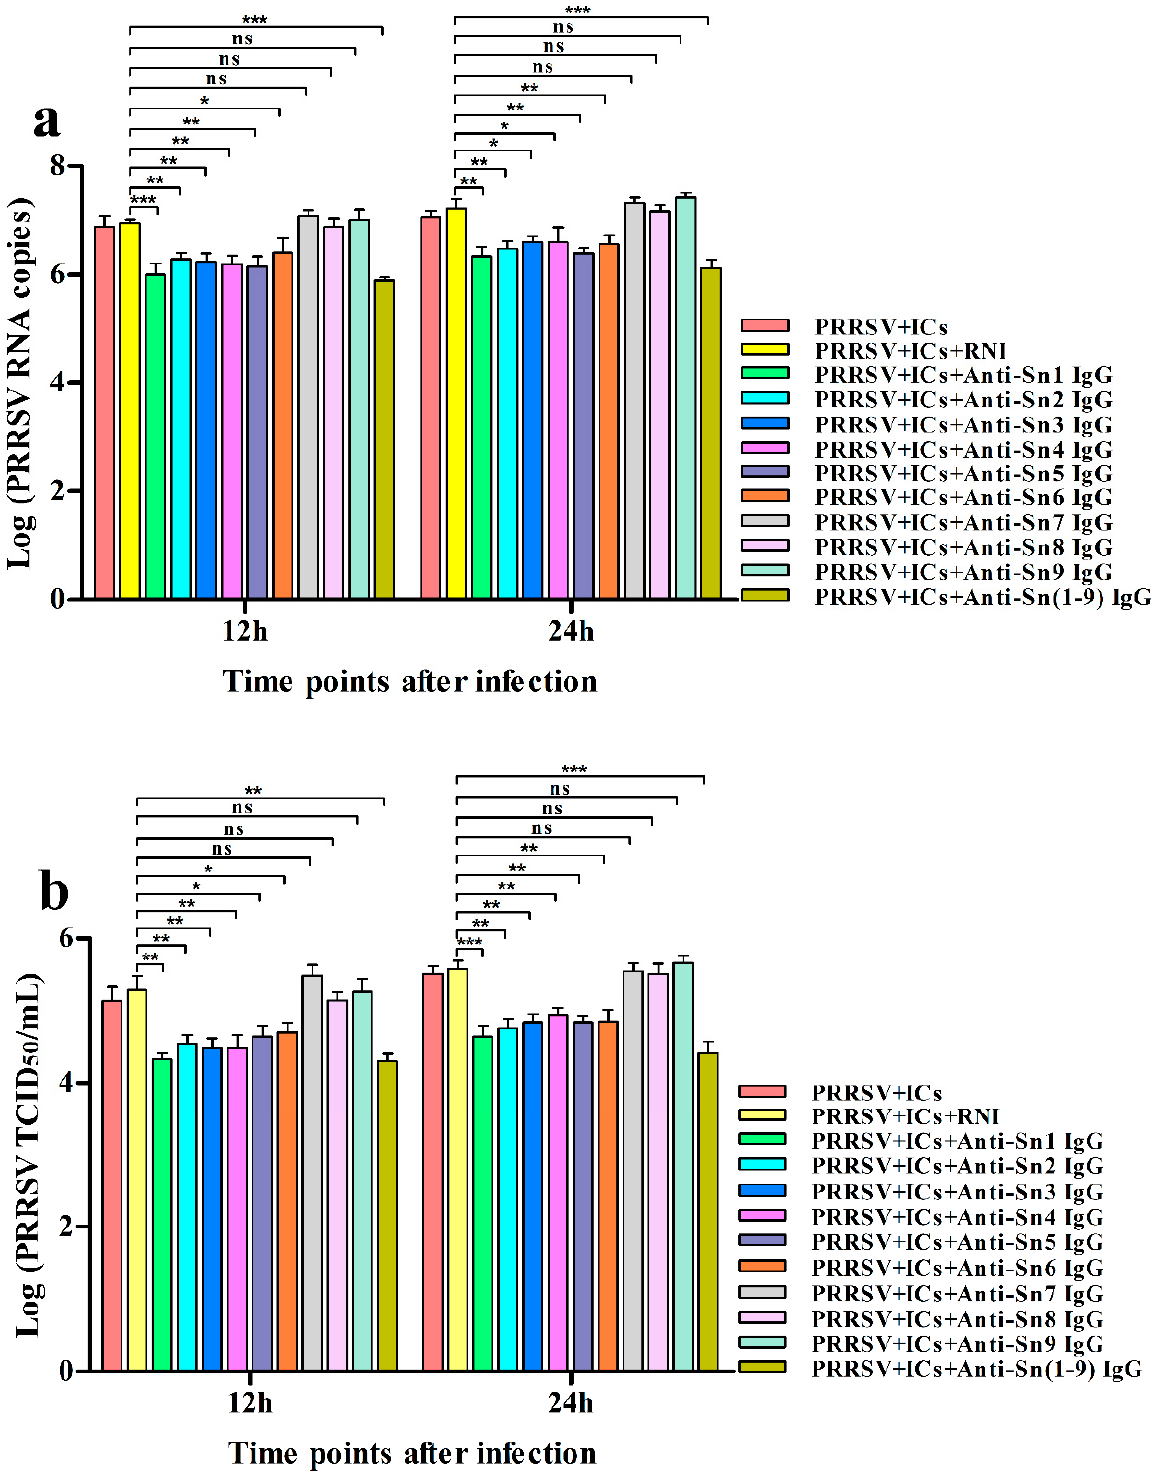
Figure 6. Effect of the antibody blocking of Sn extracellular domains on PRRSV-ADE activity in PAMs. PAMs cells were pre-blocked by each rabbit anti-Sn domain IgG or RNI and then infected with PRRSV + ICs. The RNA levels ( a ) and the virus titers ( b ) of PRRSV in cell supernatants harvested were evaluated by real-time RT-PCR and TCID 50 assay. *** p < 0.001, ** p < 0.01, * p < 0.05, ns: no significance.